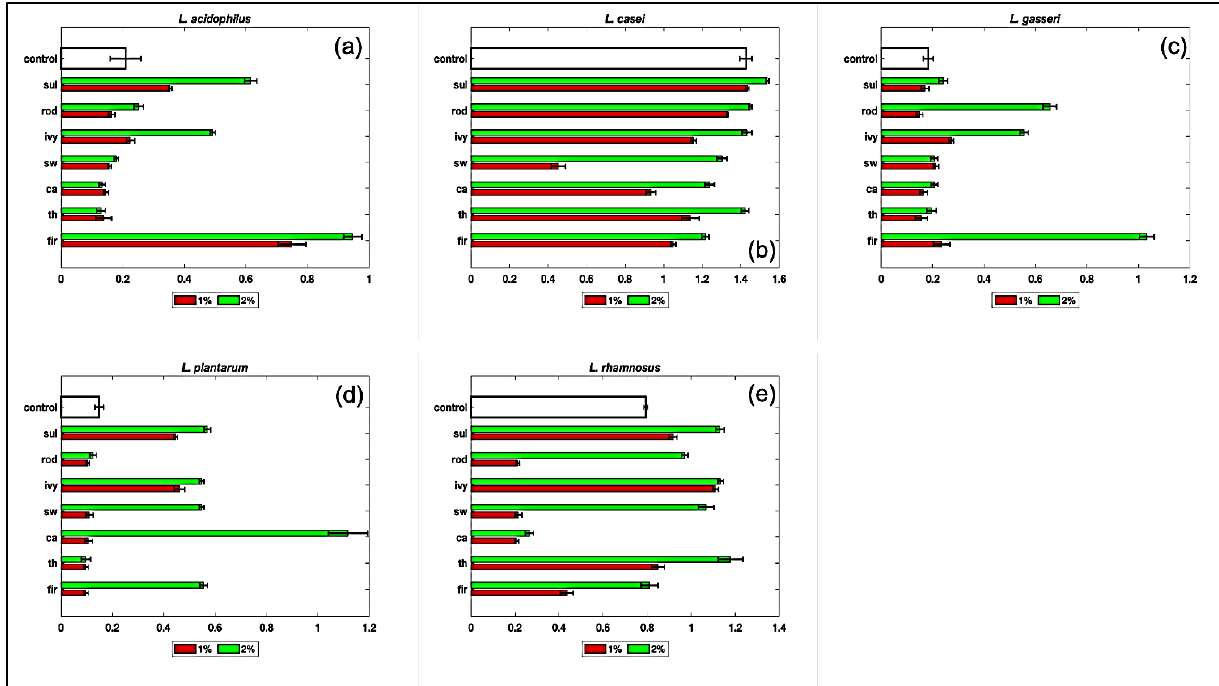
Figure 1. Effect of the monofloral honeys—added to a free glucose MRS at 1% and 2%—on the growth of five Lactobacilli: L. acidophilus (subfigure a ); L. casei (subfigure b ) ; L. gasseri (subfigure c ); L. plantarum (subfigure d ); L.rhamnosus (subfigure e ). Results are expressed as OD 600. Each control was grown in the conventional MRS. Legend: ca: cardoon honey; fir: fir honey; ivy: ivy honey; rod: rhododendron honey; sul: sulla honey; sw: strawberry tree honey; th: tree of heaven honey. Red bars represent the experiment performed with 1% honey; green bars represent the experiments performed with 2% honey. Experiments were performed in triplicate.